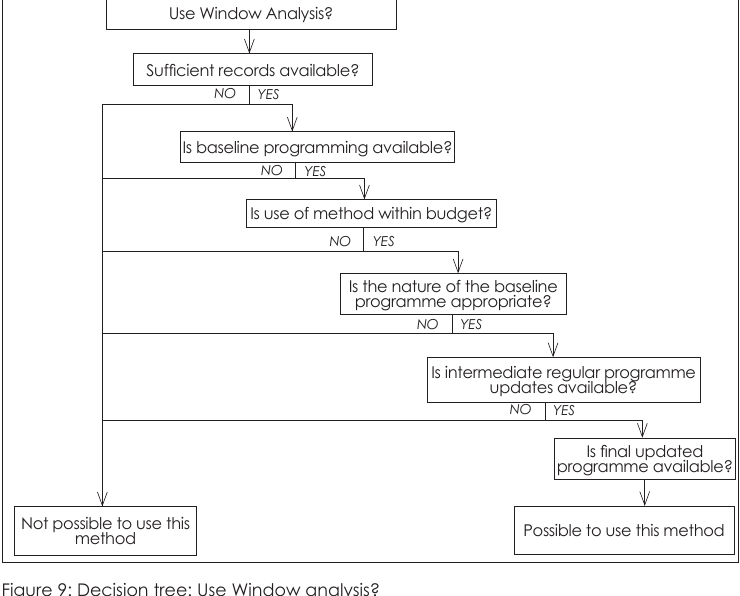
Figure 9: Decision tree: Use Window analysis?